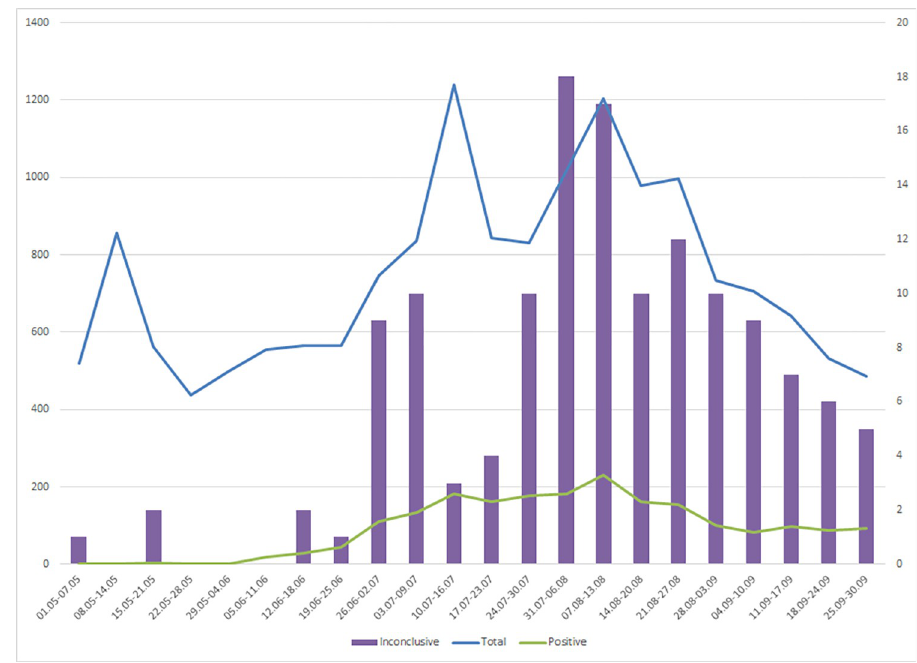
Fig 1. Weekly distribution of SARS-CoV-2 positive and inconclusive samples between May and September 2020. The blue line represents the total number of tested samples (left vertical axis); the green line–the positive cases (left vertical axis), and the purple bars–the number of inconclusive SARS-CoV-2 samples (right vertical axis).